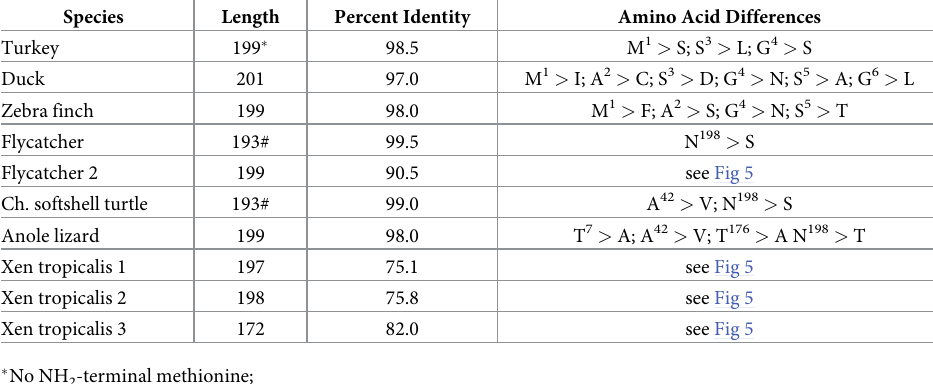
Table 4. Amino acid identities with chicken ZMAT2 in terrestrial vertebrates.